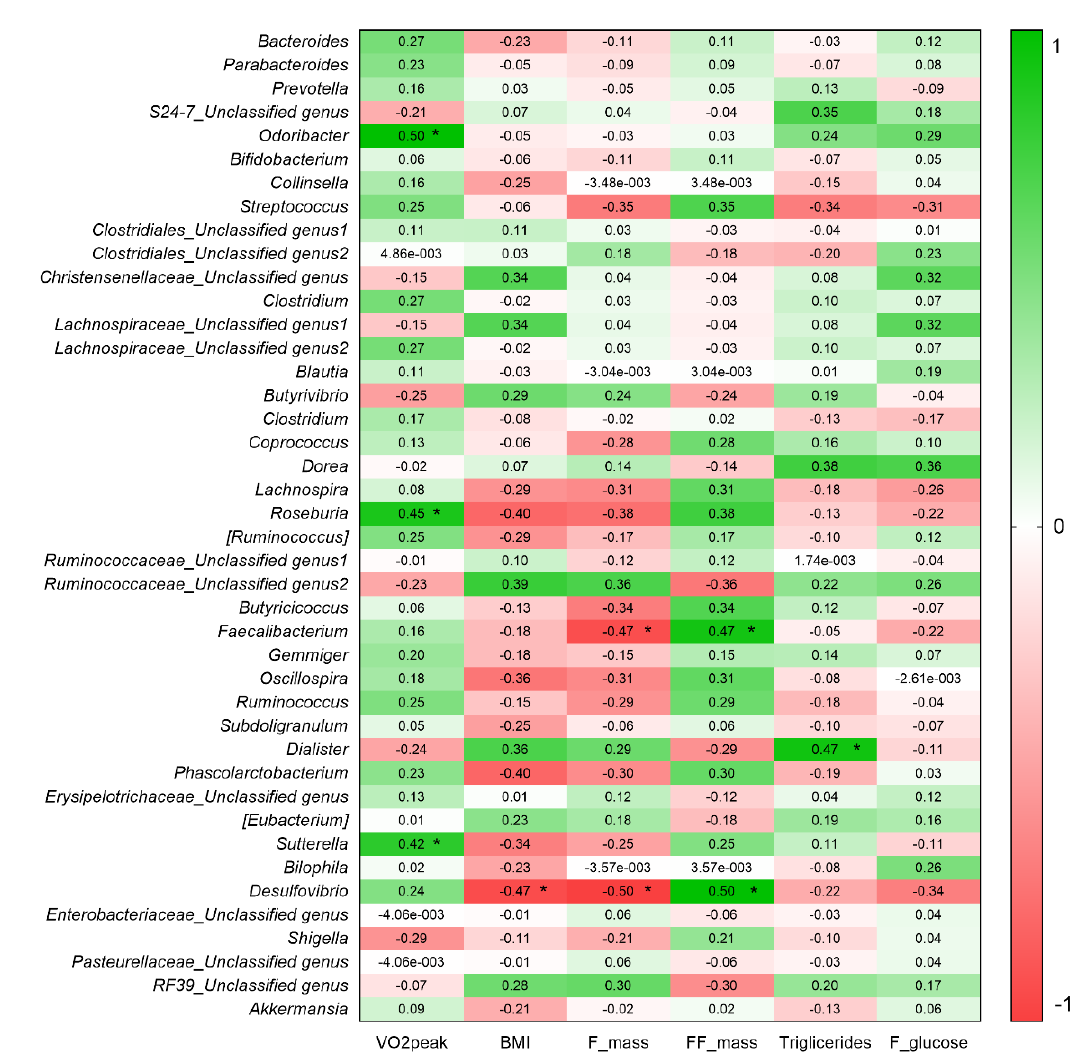
Figure 6. Association between physiological variables and relative abundance of genera (%). Pearson’s R coefficient or Spearman’s partial correlation coefficient were plotted inside of each square in the above figure. The asterisk inside a square indicates significant association between the two variables ( p < 0.05). Correlations were performed with post-intervention data.